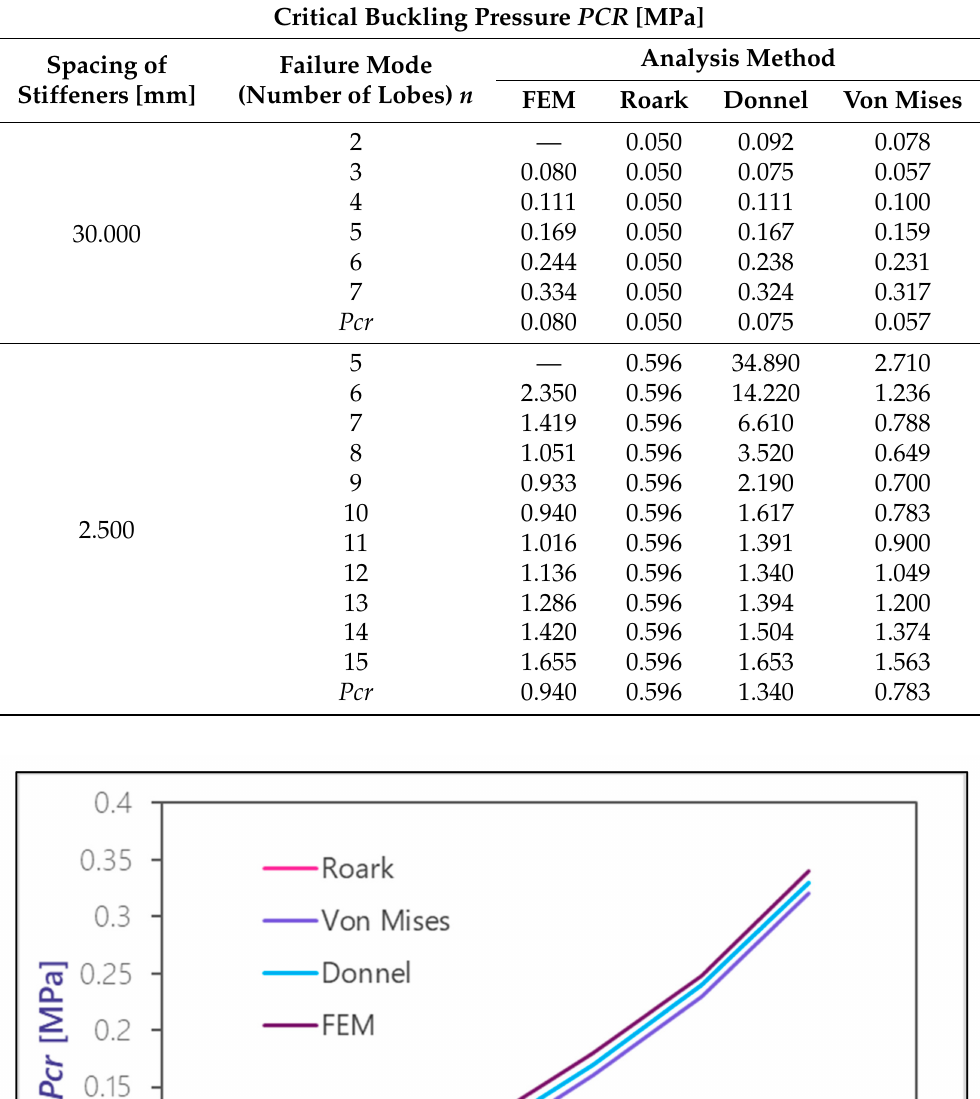
Table 6. Critical pressure for linear elastic buckling of a thin-walled steel liner.